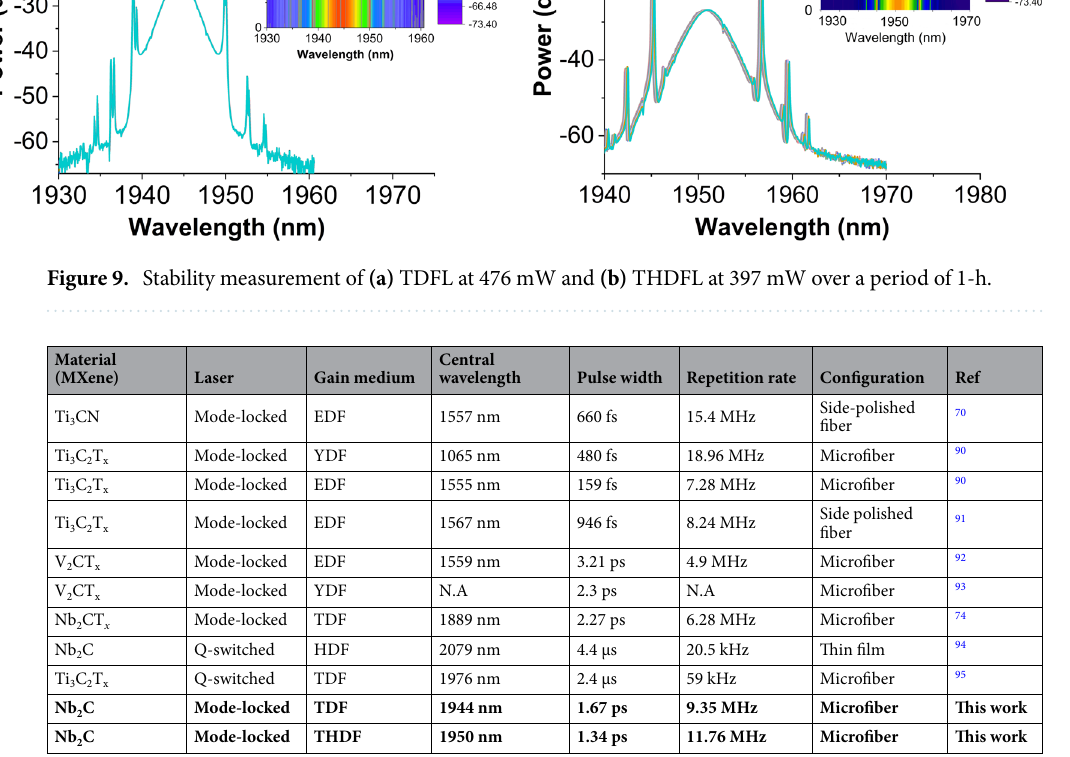
Table 2. Comparison of pulsed laser characteristics with MXene as SA. *N.A.: Not available in the paper. The bold in the table is to highlight the results from this work.